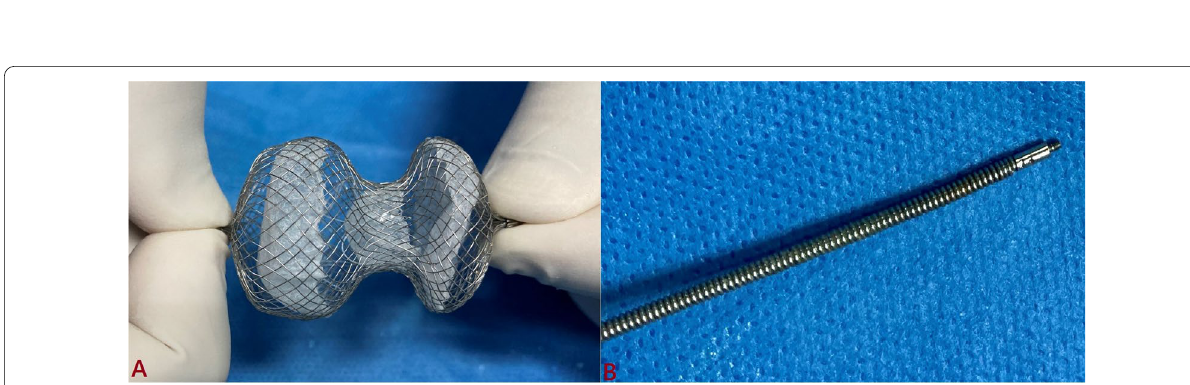
Fig. 2 Cocoon septal occlude (CSO) is filled with three polypropylene woven fabrics ( A ); pin vice connector of CSO ( B